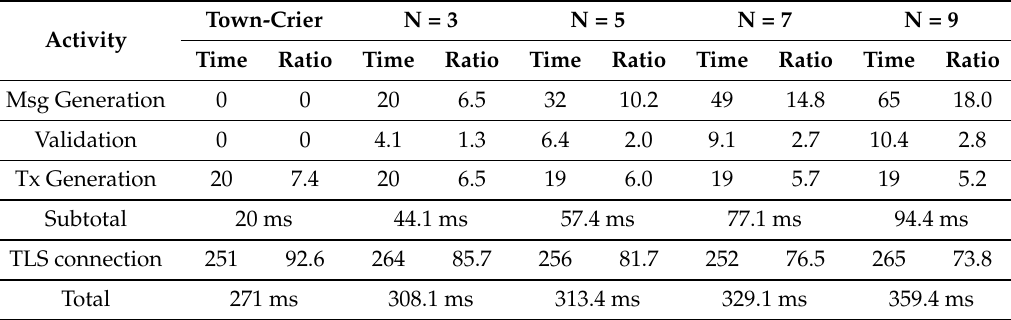
Table 2. Response Time Breakdown (N = Number of Oracle Servers, Unit: Time (ms)/Ratio